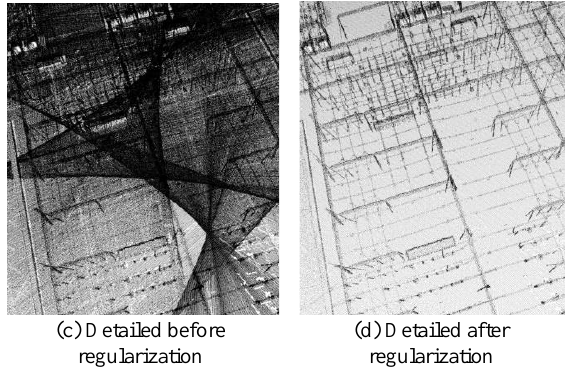
Figure 3. Overview and detailed snapshot of the experiment data before and after the data regulation, and the (c)(d) are rendered with grey to better show the uneven